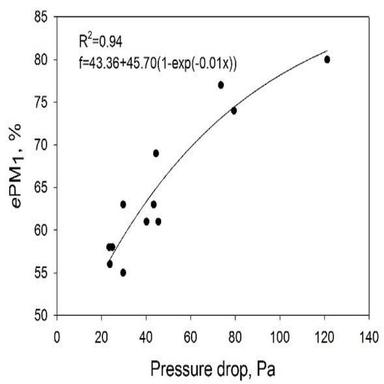
Relationship between filtration efficiency (ePM1) and pressure drop.